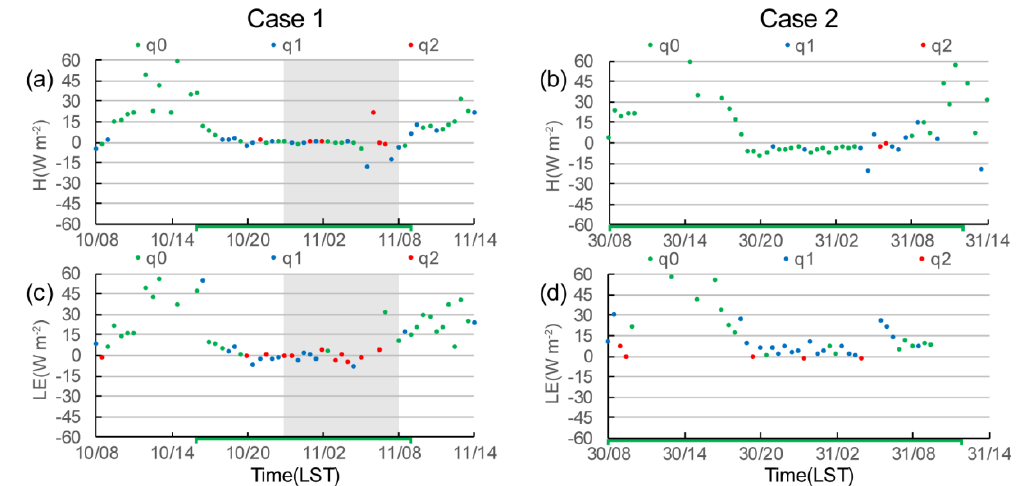
Figure 14. Sensible- and latent-heat fluxes inland (10 m AGL). ( a ) Case 1, sensible. ( b ) Case 2, sensible. ( c ) Case 1, latent. ( d ) Case 2, latent. Averaging interval for the fluxes is 30 min. Missing data are either out of range or doubtful. Markings are the same as those in Figure 12.